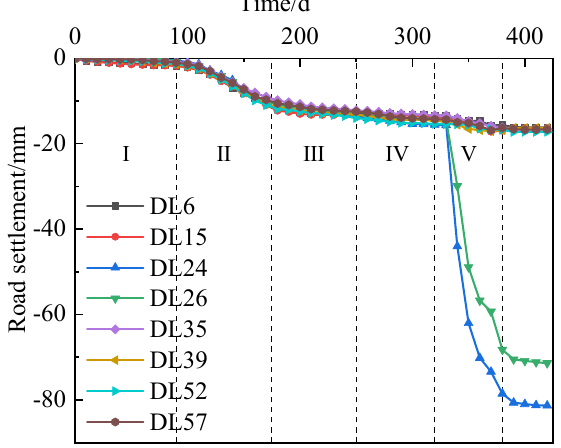
Figure 10. Change curve of the groundwater level outside the pit.